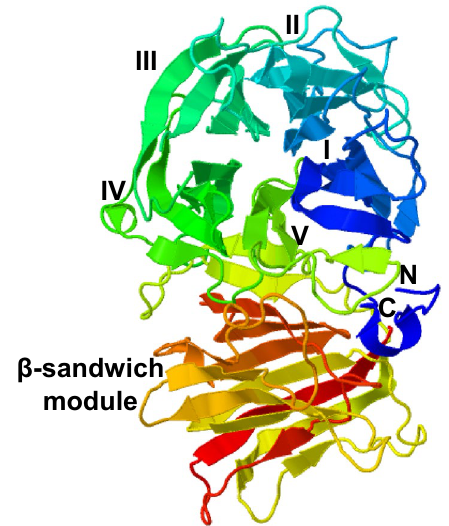
Figure 1. MdesGH32 sequence characterization. ( a ) Schematic representation of coding (cDNA) and genomic (gDNA) sequences of MdesGH32 . The exons are represented by rectangular boxes. ( b ) Protein sequence of MdesGH32 showing three conserved motifs (bold and italicized font) of glycoside hydrolase 32 proteins. Underlined amino acids represent the putative signal peptide with the cleavage site marked by a filled triangle. Amino acids in red, bold font depict the sequence used for peptide antibody synthesis. ( c ) Modeled secondary structure of MdesGH32 showing presence of a five-bladed β-propeller (I, II, III, IV, V) structure at the N-terminus (N) that is connected to a β-sandwich module at the C-terminus (C) resembling the structure of